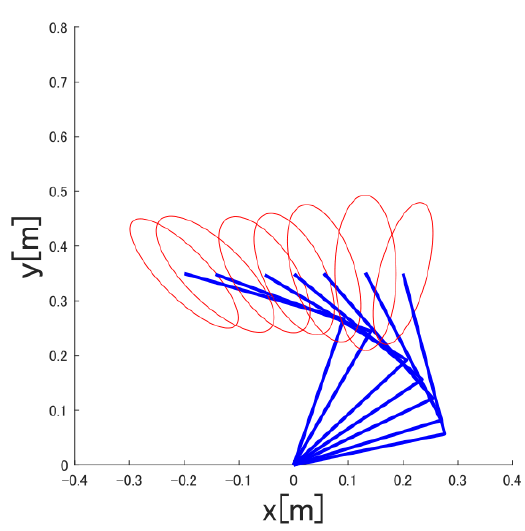
Figure 7. Multi-joint viscoelasticity.